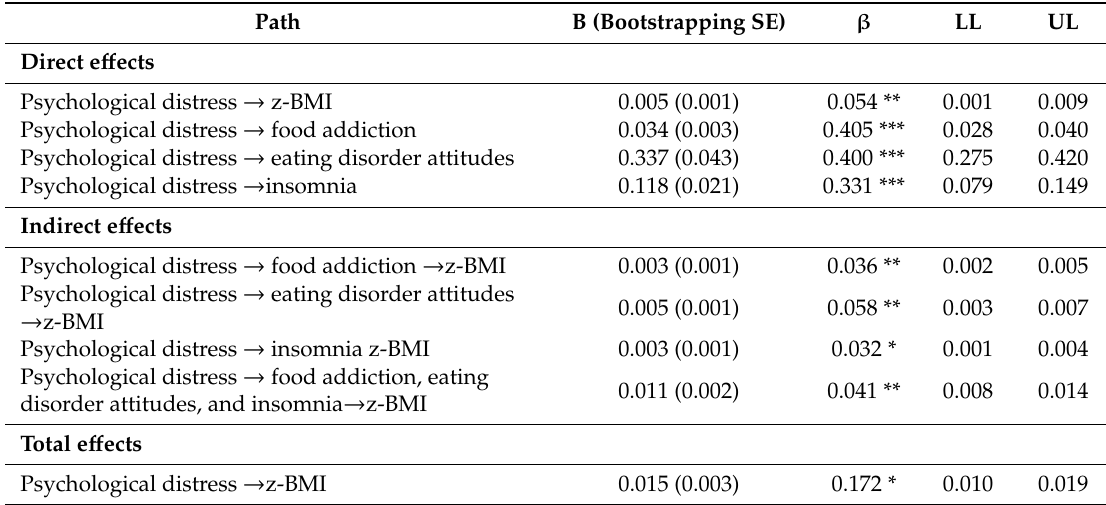
Table 4. Direct, indirect, and total e ff ects of the path